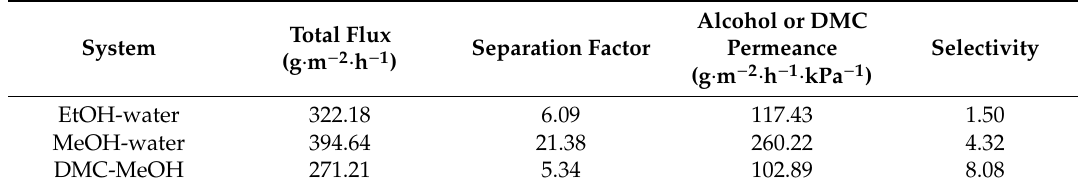
Table 6. Pervaporation performance of the ZIF-71 membrane in the separation of 5 wt% ethanol-water,